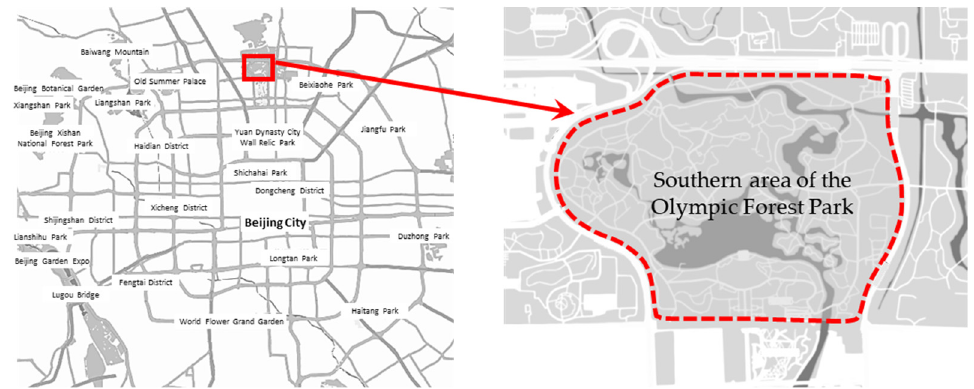
Figure 1. Geographical location of the Olympic Forest Park, which is the study area.